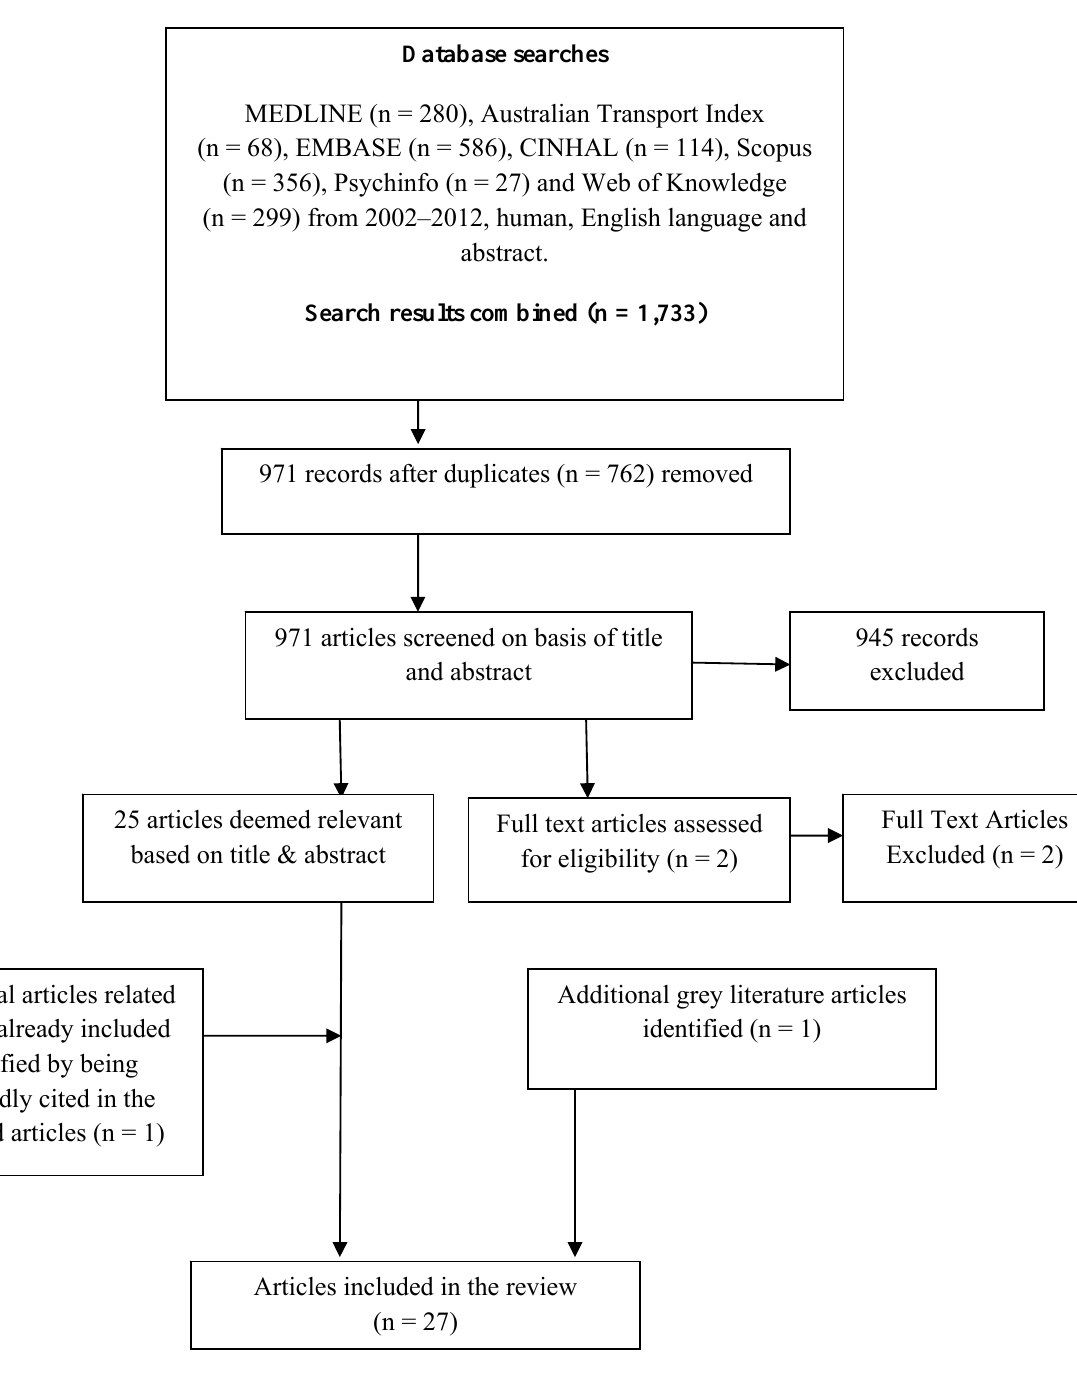
Figure 1. Summary of Search Strategy and Identification of Articles Included in the